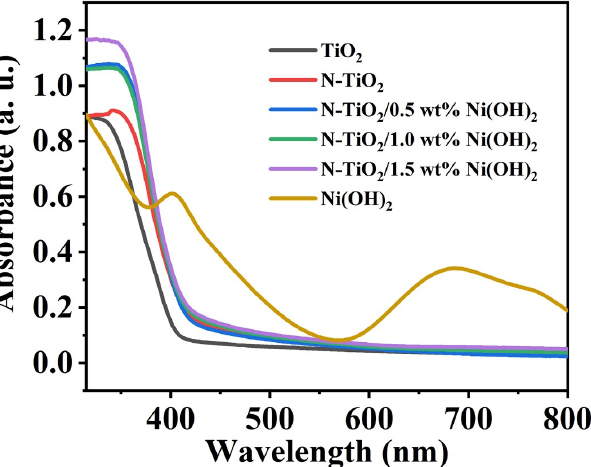
Figure 4. UV-Vis diffuse reflectance absorption spectra of Ni(OH) 2 , TiO 2 , N-TiO 2 , N-TiO 2 /Ni(OH) 2 Figure 4. UV-Vis di ff use re fl ectance absorption spectra of Ni(OH) 2 , TiO 2 , N-TiO 2 , N-TiO 2 /Ni(OH) 2 with di ff erent Ni(OH) 2 contents, respectively. with different Ni(OH) 2 contents,